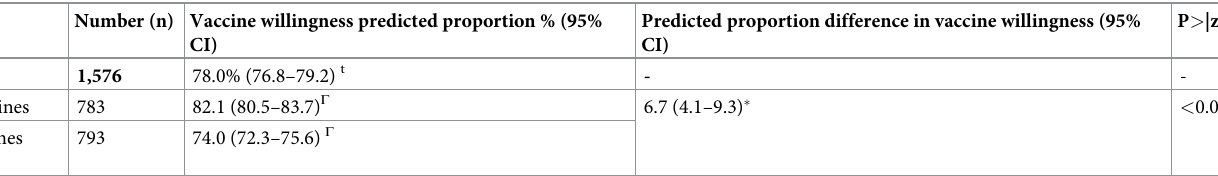
Table 3. Willingness to receive a new vaccine by college status, population average effects �